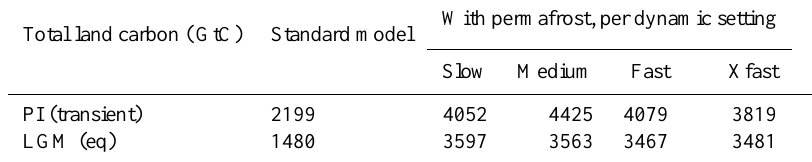
Table 7. Modelled total land carbon stocks per model setting.